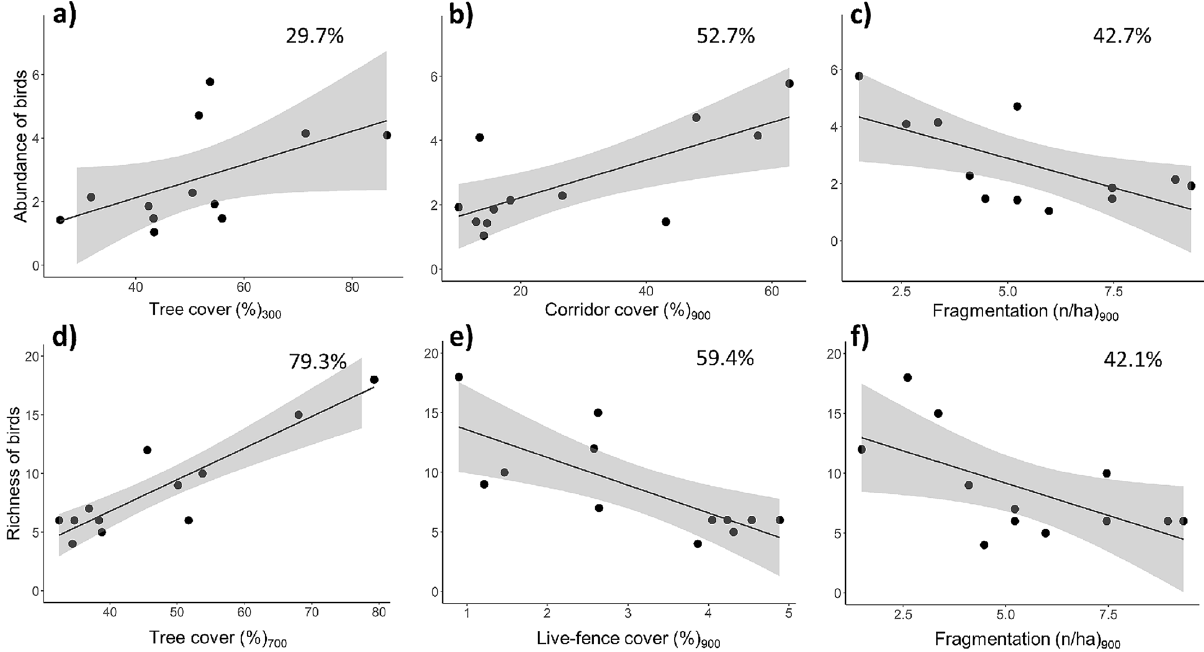
Figure 3. Univariate relationships between the landscape metrics and the abundance and species richness of highly forest-dependent birds in restoration plots in southern Costa Rica. The subscript indicates the scale of effect or landscape radius (m). The black line shows the predicted estimates from the regressions using a generalized linear model. The gray area represents the 95% confidence interval. The percentage of explained deviance (pseudo-R 2 ) is shown at the top of the panels. Black points indicate the restoration plots (n =